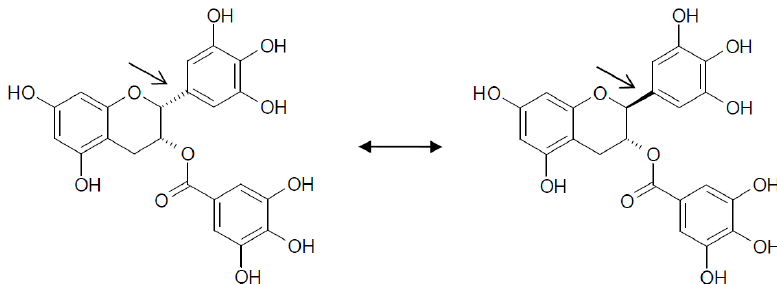
Figure 2. ( − )EGCG can convert into ( − )GCG [73,74]. Epimerization of EGCG significantly changes the three-dimensional structure of this compound that can interact differently with proteins that are relevant to Down